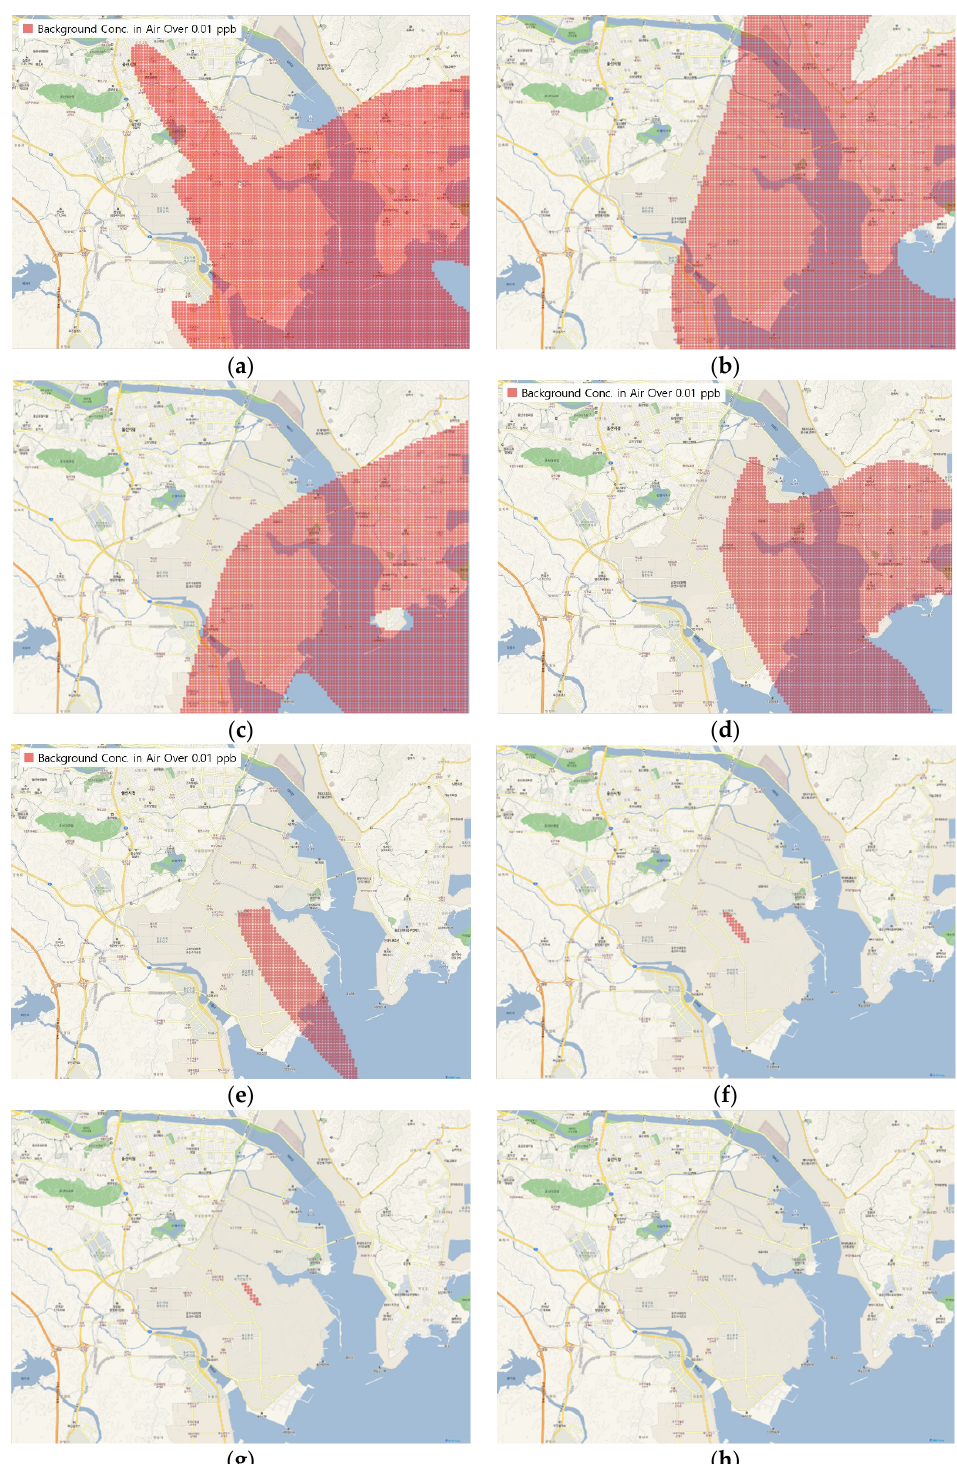
Figure 3. Concentration distribution maps of benzyl chloride in the air: ( a ) Day 1 (2017-01-01); ( b ) Day 2 (2017-01-02); ( c ) Day 3 (2017-01-03); ( d ) Day 20 (2017-01-20); ( e ) Day 40 (2017-02-09); ( f ) Day 80 (2017-03-20); ( g ) Day 97 (2017-04-06); ( h ) Day 99 (2017-04-08).